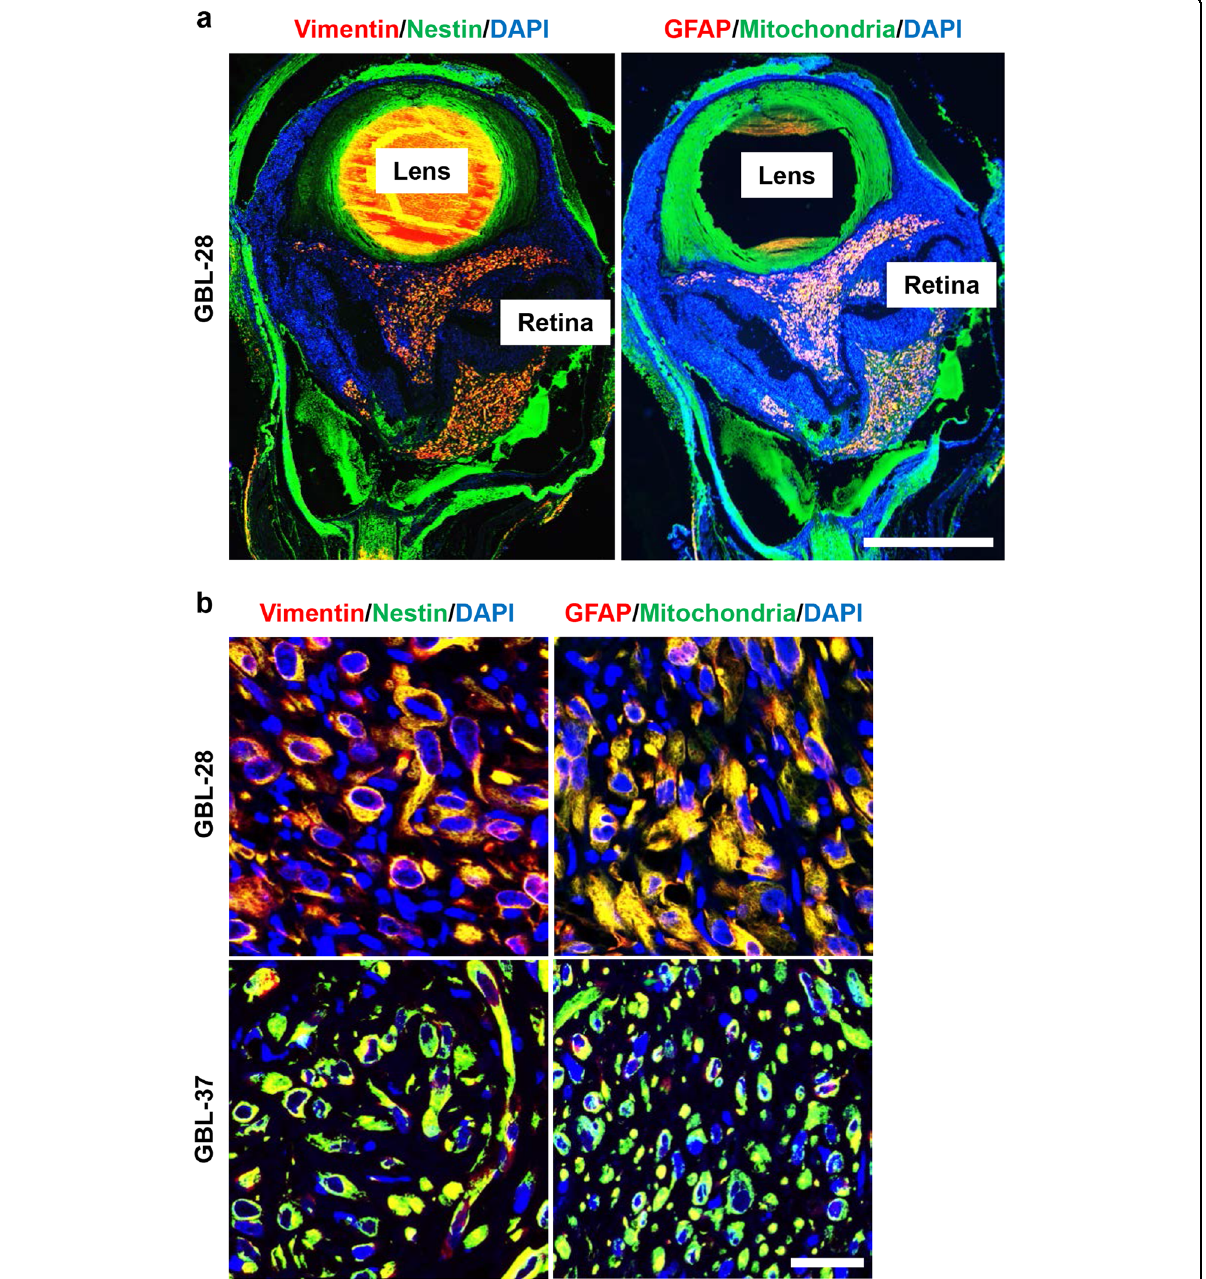
Fig. 4 Immunohistochemical characterization of PDX tumors in the vitreous cavity. a Representative images of eyeball sections that were stained using DAPI and antibodies speci fi c for human mitochondria, GFAP, vimentin, and nestin. Scale bar: 1 mm. b Representative magni fi ed images of eyeball sections that were stained using antibodies speci fi c for human mitochondria, GFAP, vimentin, and nestin. Scale bar: 20 μ